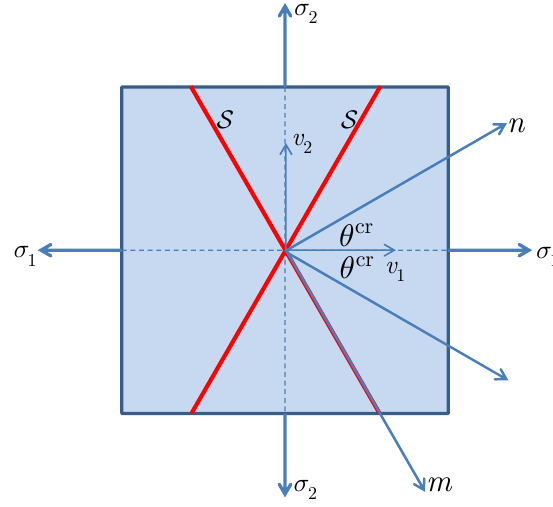
Figure 4. Definition of the discontinuity